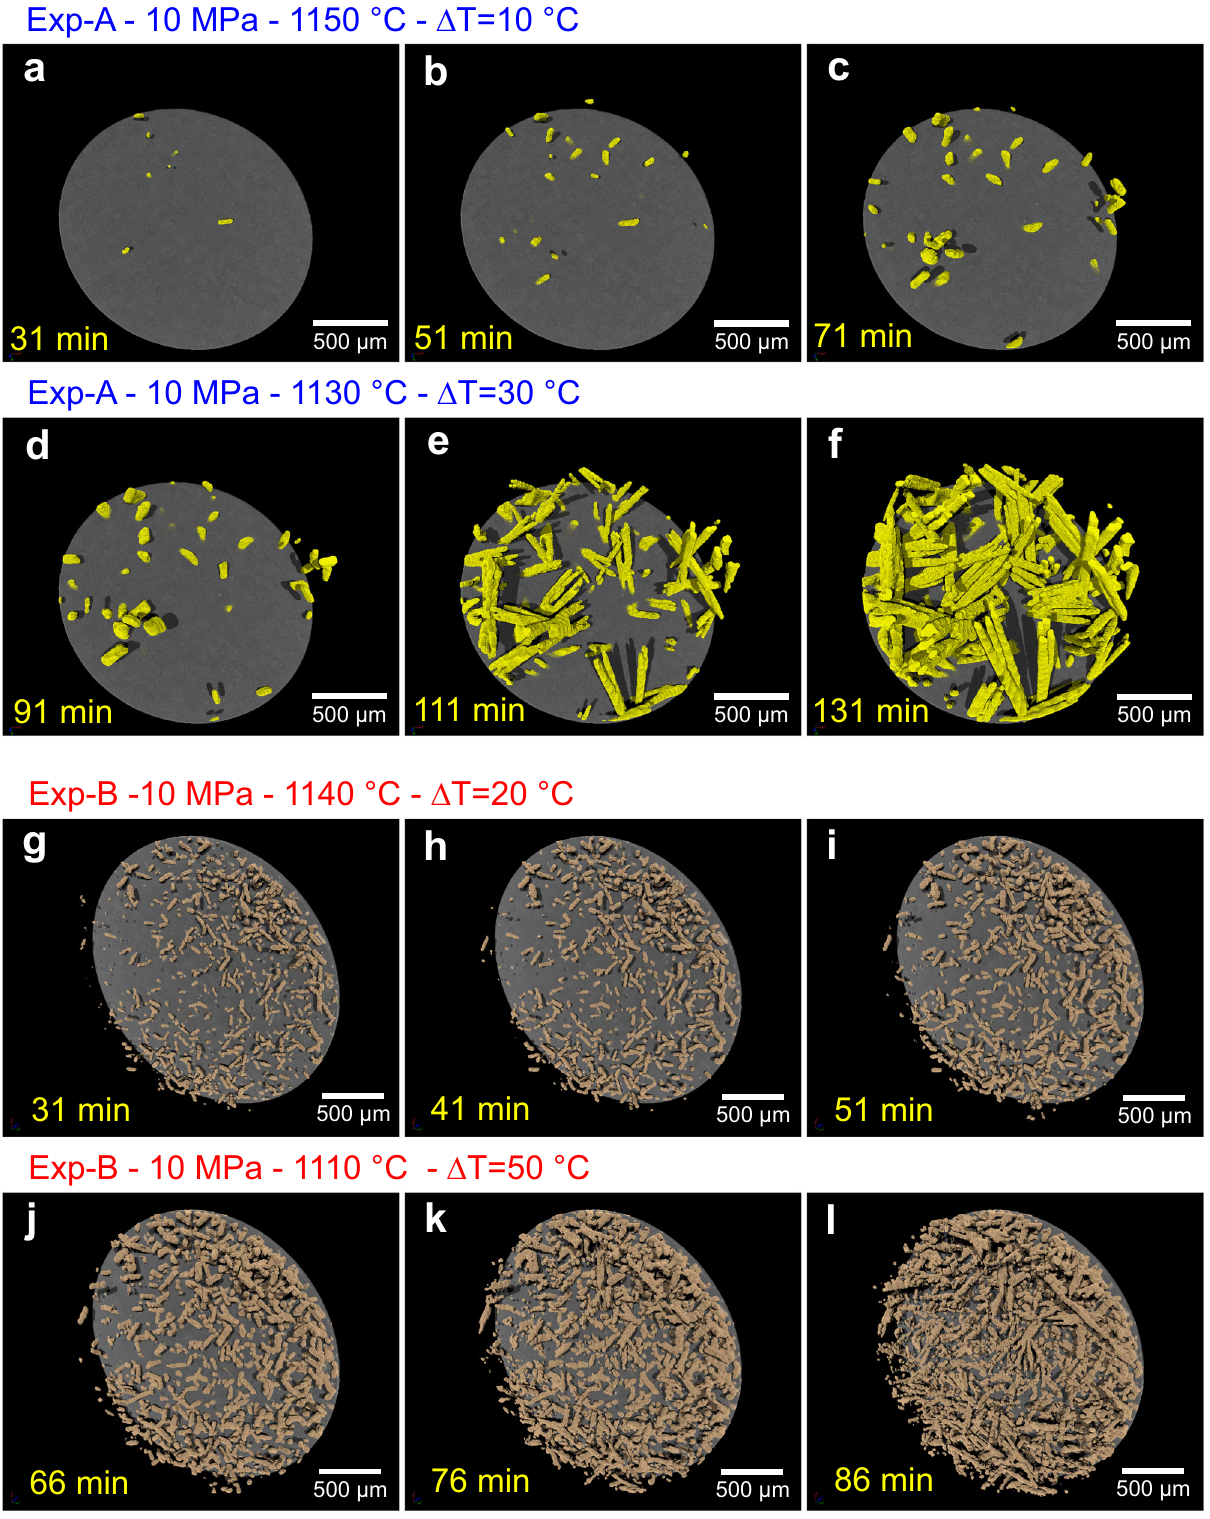
Fig. 2 Crystallisation of a hydrous trachybasaltic melt through time during single-step cooling experiments at 10 MPa. a – c Volume renderings show clinopyroxene crystallisation through time during the experiment Exp-A at 1150 °C and Δ T = 10 °C. d – f Volume renderings show clinopyroxene crystallisation through time during the experiment Exp-A at 1130 °C and Δ T = 30 °C. g – i Volume renderings show clinopyroxene crystallisation through time during the experiment Exp-B at 1140 °C and Δ T = 20 °C. j – l Volume renderings show clinopyroxene crystallisation through time during the experiment Exp-B at 1110 °C and Δ T = 50 °C. a – l The undercoolings ( Δ T ) investigated are calculated with respect to the clinopyroxene liquidus. The time in yellow reported in each panel indicates the time passed from the beginning of the